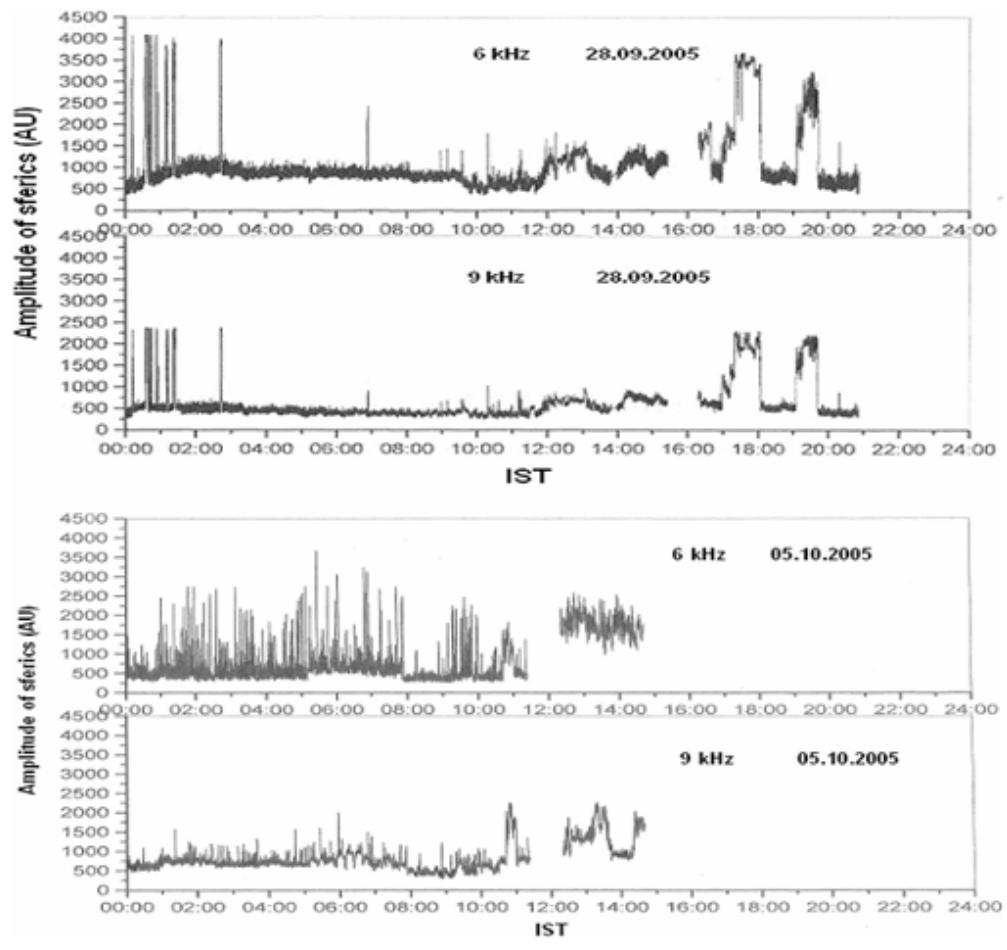
Fig. 9. Diurnal variations of sferics observed over Agartala. Upper two records are at 6 and 9kHz on 28 September 2005. The records show typical spikes beginning around midnight. The lower two graphs show the existence of spikes on 5 October